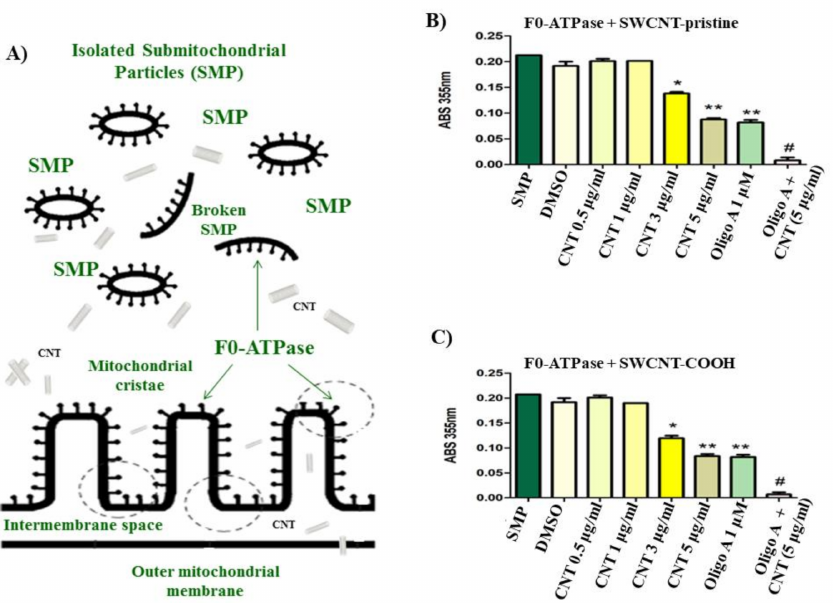
Figure 2. ( A ) Schematic representation of carbon nanotubes (CNT) interacting with isolated rat liver submitochondrial particles (SMP as F0-ATPase). ( B , C ) Results of experimental in vitro evaluation of the F0-ATPase inhibition induced by CNT (i.e., CNT as SWCNT-pristine or SWCNT-COOH) using F0-ATPase under the different conditions described in the Material and Methods Section as treatments: (i) untreated submitochondrial particles control (SMP as F0-ATPase), (ii) DMSO-treated SMP, (iii) CNT-treated SMP (1–5 µ g/mL), (iv) oligomycin A-treated SMP (oligomycin A is a specific F0F1-ATPase inhibitor used as a positive control), and (v) treated SMP mixed with SWCNT or SWCNT-COOH at concentration of 5 µ g/mL + oligomycin A (1 µ M) to mimick synergistic effects on F0-ATPase inhibition, which was performed as an additional control group. Results are representative of three experiments (n = 3). Symbols (*, **, #) were used to denote statistical differences ( p < 0.05) between the evaluated experimental groups used in the in vitro assay containing the